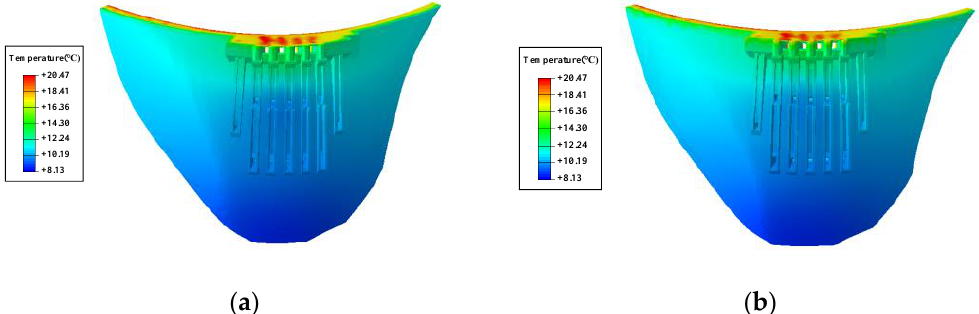
Figure 11. The surface temperature of the arch dam during five days in summer. In summer, the upstream water body is significantly affected by solar radiation, and the temperature of the water surface increases due to heat absorption, which affects the nearby dam body. Figure 12 shows the impact of water temperature correction on the dam temperature field. It can be observed that after the water temperature correction, the temperature of the dam’s surface near the top increases to a certain extent.